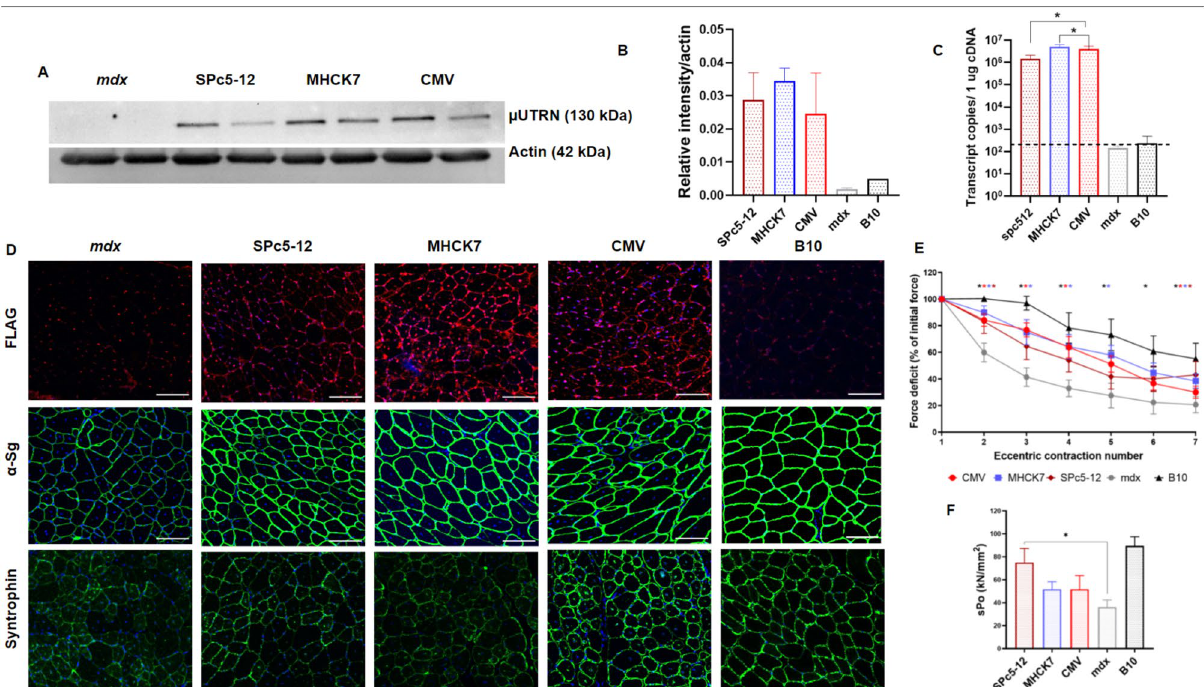
Figure 6. Muscle-specific SPc5-12 and MHCK7 promoters drive µUtrn expression and ensure force improvement after intramuscular injection at dose 2 × 10 12 vg/TA in mdx mice. ( A ) Western blot analysis of recombinant µUtrn expression in TA muscles after 2 weeks post injection, with α-actin as the loading control. Unprocessed full-length blots are presented in Supplementary Figure S10. ( B ) Hco-μUtrn protein levels in rAAV9-Promoter-Hco-µUtrn-treated mdx TA muscles determined via western blot and normalized to α-actin levels. ( C ) Analysis of µUtrn transgene expression via RT-qPCR. Values are expressed as transcript copies per 1 µg cDNA. The dashed line represents the detection levels of negative controls. ( D ) Representative images of µUtrn-FLAG (FLAG), α-sarcoglycan (a-Sg), and α1-syntrophin immunofluorescence in TA muscle cross- sections. Nuclei were counterstained with Hoechst 33,342 (blue). Scale bars, 100 μm. ( E ) Percentage force drop following 20% eccentric contraction and ( F ) specific force of TA muscles from mdx mice administered rAAV9- µUtrn-FLAG compared to those from vehicle control mice. Maximal isometric force and cross-sectional area of TA muscles are present in Supplementary Figure S11. All values are presented as the mean ± SEM (N = 8 muscles), and statistical significance was set at P ≤